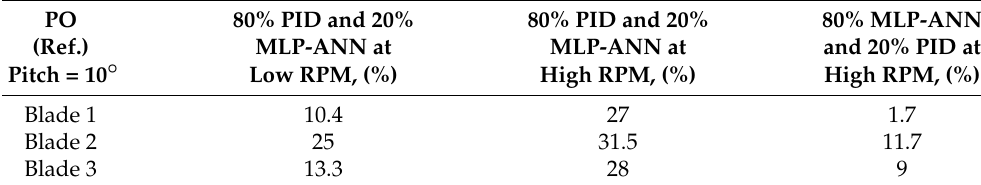
Table 3. Percentage overshoot of the hybrid controller for the first